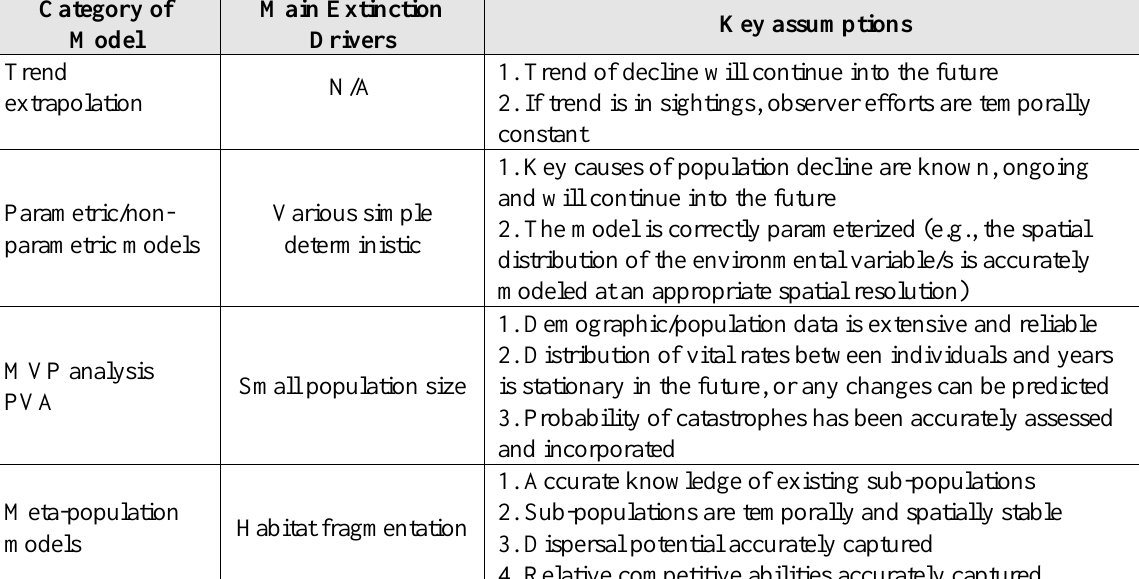
Table 2. Key extinction drivers and assumptions underlying each of the identified extinction forecasting models. Note: Many of the models are sufficiently flexible to incorporate additional extinction drivers and such a classification is of mainly heuristic